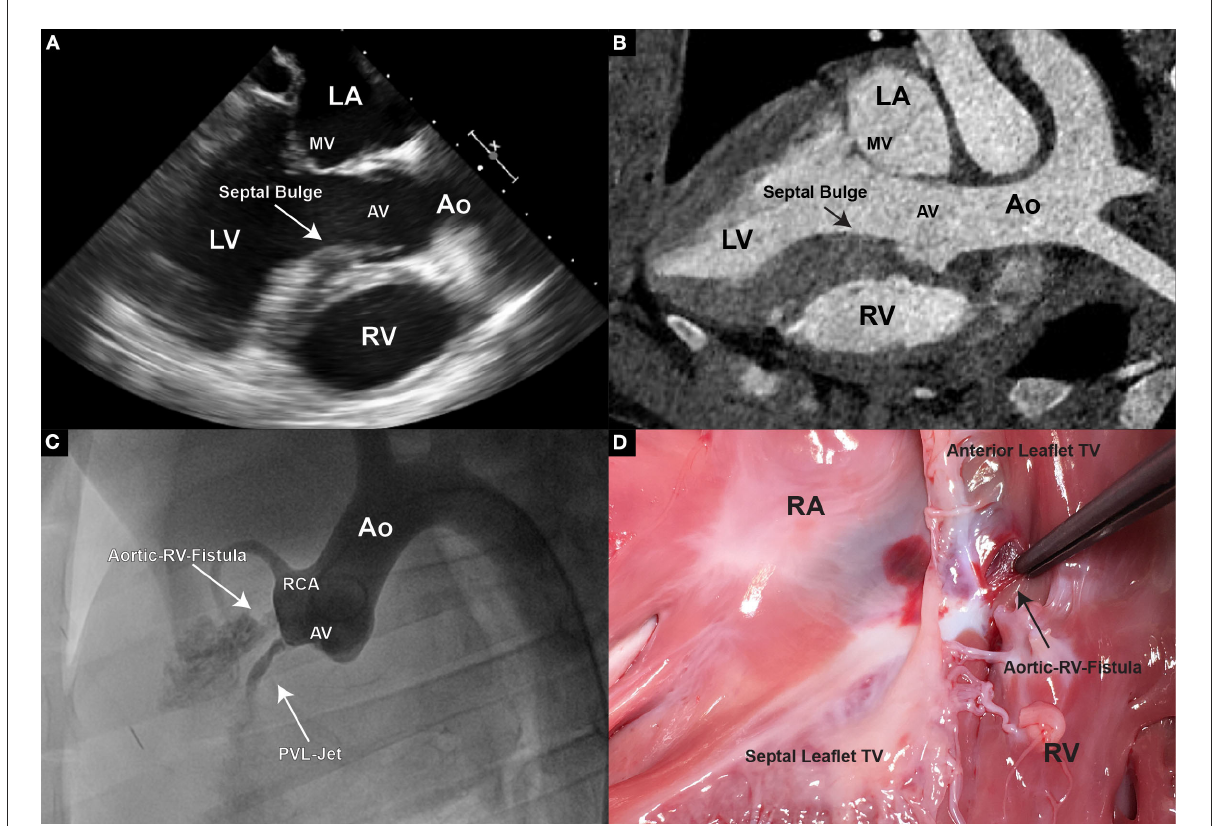
FIGURE3 (A) In TEE, pigs display a unique feature of thickened septal wall. Especially the portion directly beneath the aortic valve, corresponding to the location of the RCC. Thickening of this region becomes prominent, especially during end-systole and early diastole; (B) In CT however, usually only general thickening of the septal wall can be observed, and often no prominent “bulge” is detectable; (C) An aortogram is performed following an erroneous piercing in the RCC region. A direct flow of contrast to the right ventricle could be observed demonstrating an aorto-right ventricular communication; (D) Upon pathological examination a fistula connecting the aortic root and the right ventricle was found.